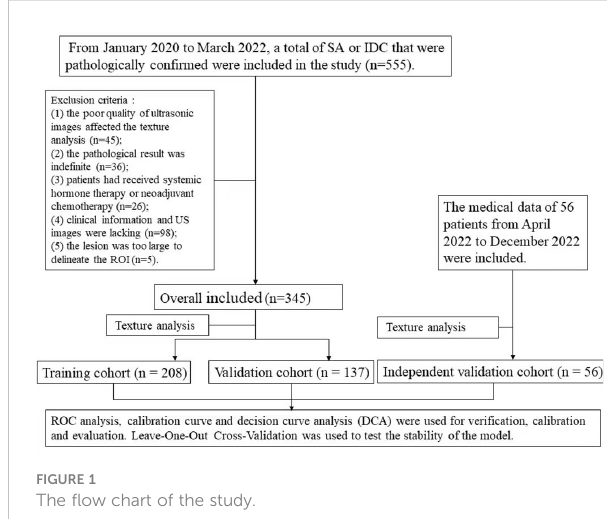
FIGURE 1 The fl ow chart of the